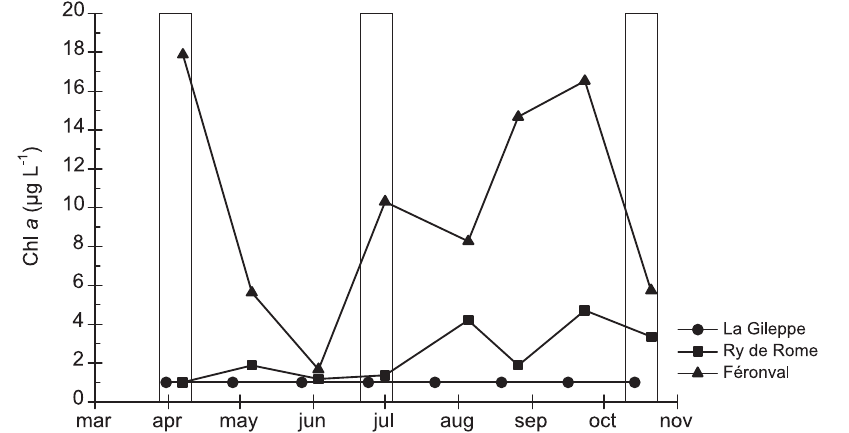
Fig. 1. Chlorophyll a concentrations. Chlorophyll a concentrations (average values from the three analysed water layers) from April to October 2010 measured in La Gileppe (dot), Ry de Rome (square) and Fe´ronval (triangle). Boxes indicate sampling periods for both chemical and BCC analyses.